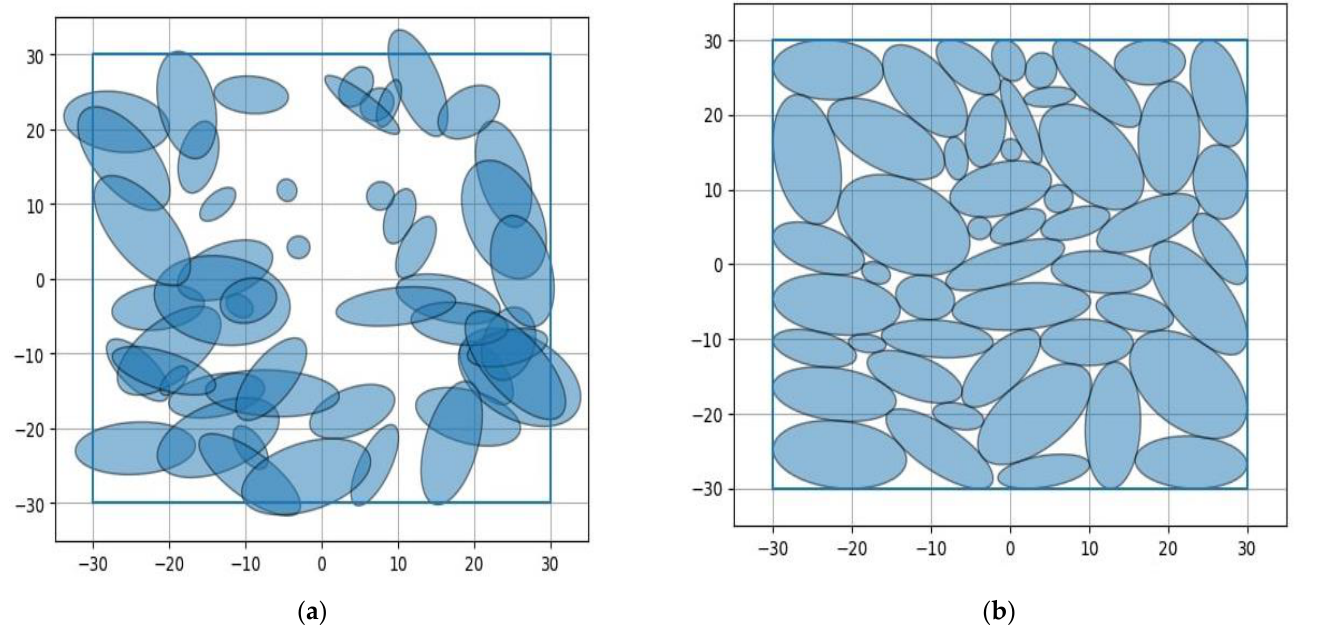
Figure 5. The continuous MCLP of 50 ellipses: ( a ) starting point and ( b ) local optimum.